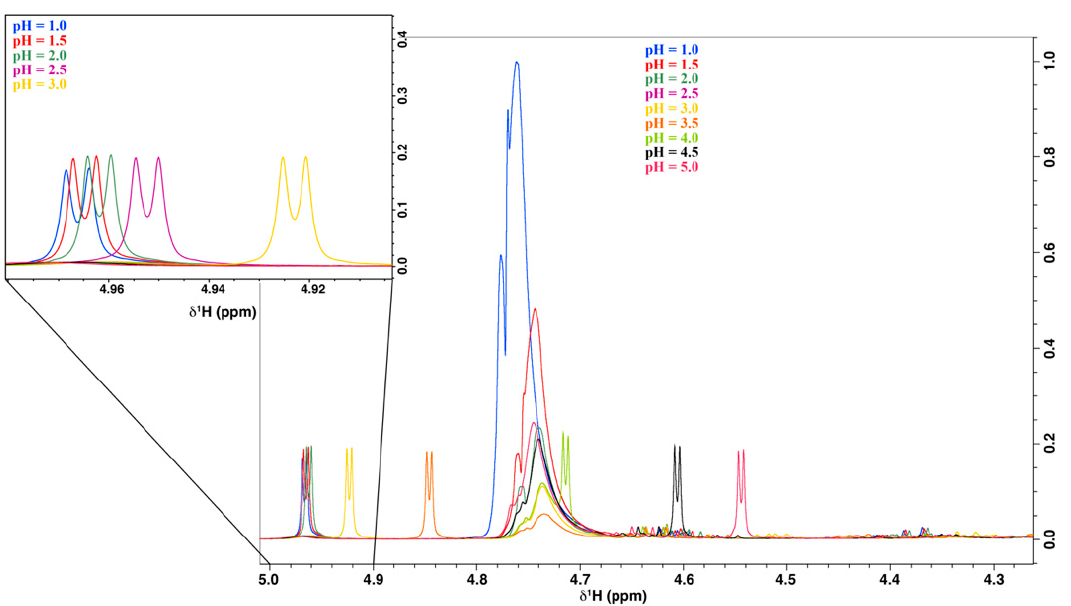
Figure 5. Variations in the ascorbic acid H1 chemical shift in acerola powder solution as a function of pH (400 MHz, 300 K, pH 1.0 to 5.0, D 2 O).